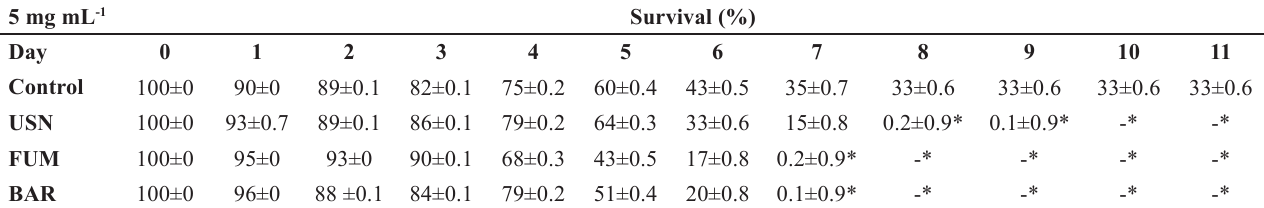
Table 1 . Percentage of termite worker survival following treatment with usnic (USN), fumarprotocetraric (FUM) and barbatic (BAR) acids at concentration of 5 mg mL -1 . Symbol (-) indicates 0% survival. Treatments were compared with the control and among treatments. Asterisk (*) indicates a significance difference at p< 0.05.